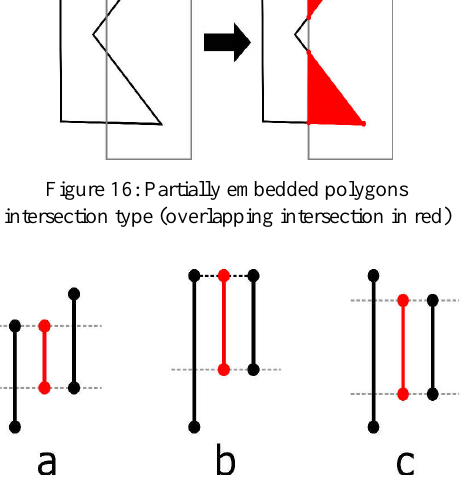
Figure 17: Partially (a, b) and fully (c) embedded intersection type (overlapping intersection in red)